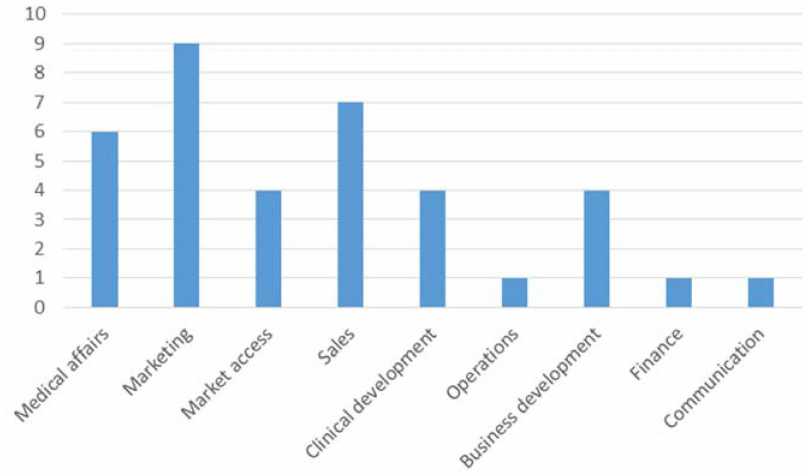
Figure 5. Perceptions on the value of transparency code data.